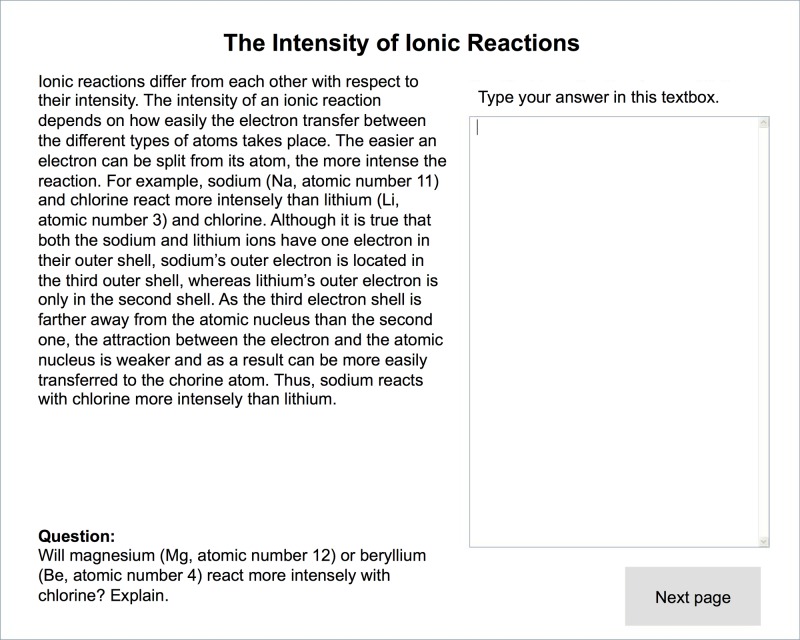
Screenshot of a reduced introductory instructional explanation with inference prompt (translated from German).